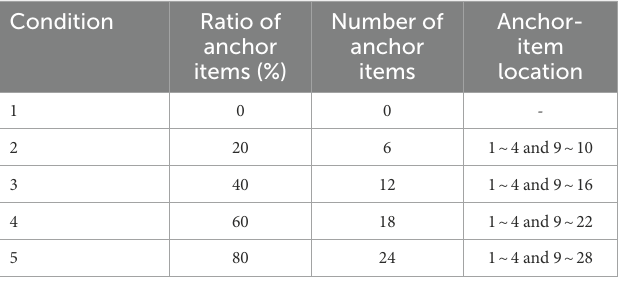
TABLE 3 Anchor-item settings for conditions with 30 items in Study 2.